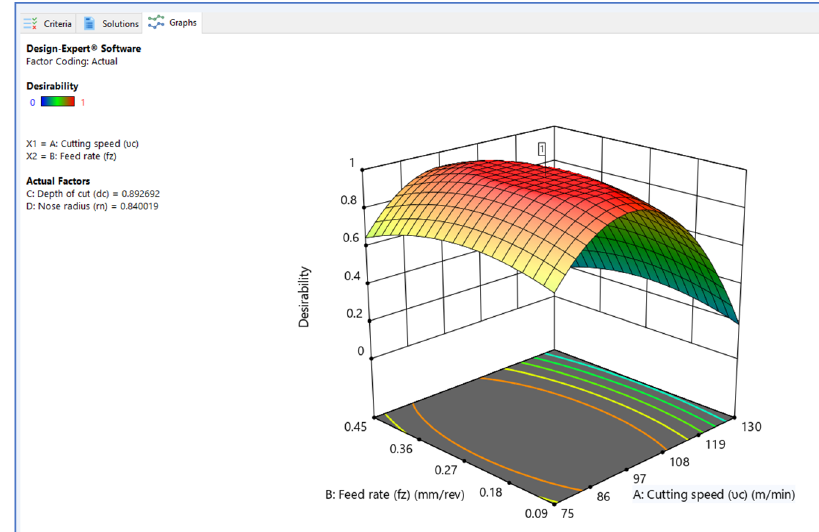
Figure 9. Surface plot on desirability (V c vs. F z ).